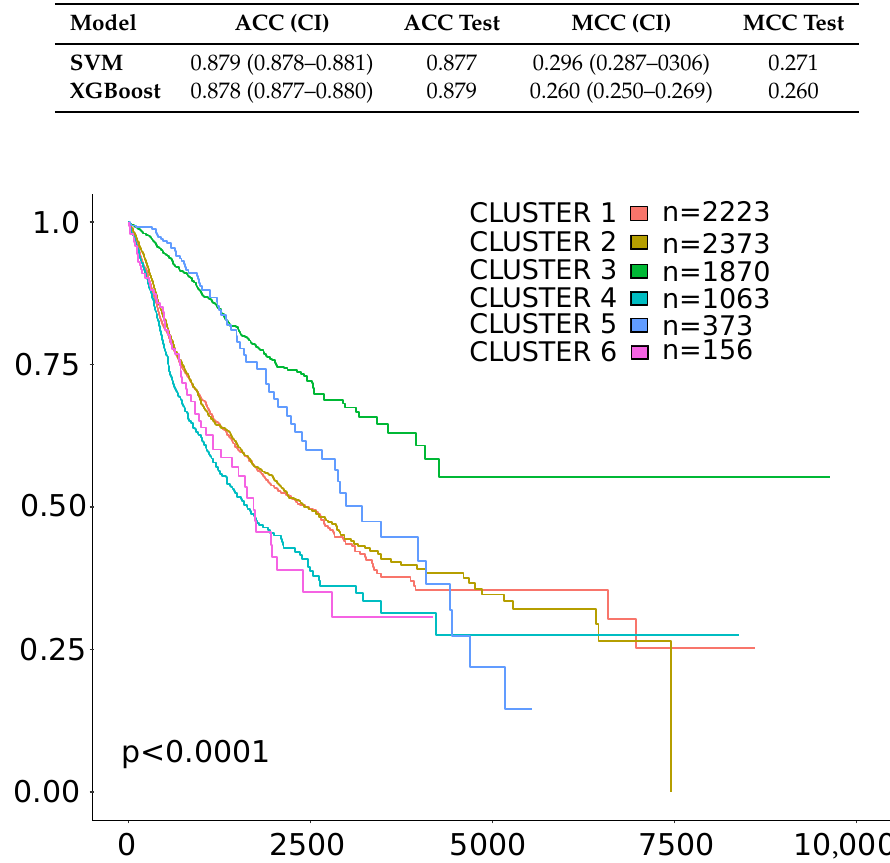
Figure 2. Kaplan-Meier Overall Survival (OS) curves of the six immune subtypes described in Thorsson et al. [17] using the case cohort included in the present study. Time is expressed in days; log-rank test p-value is